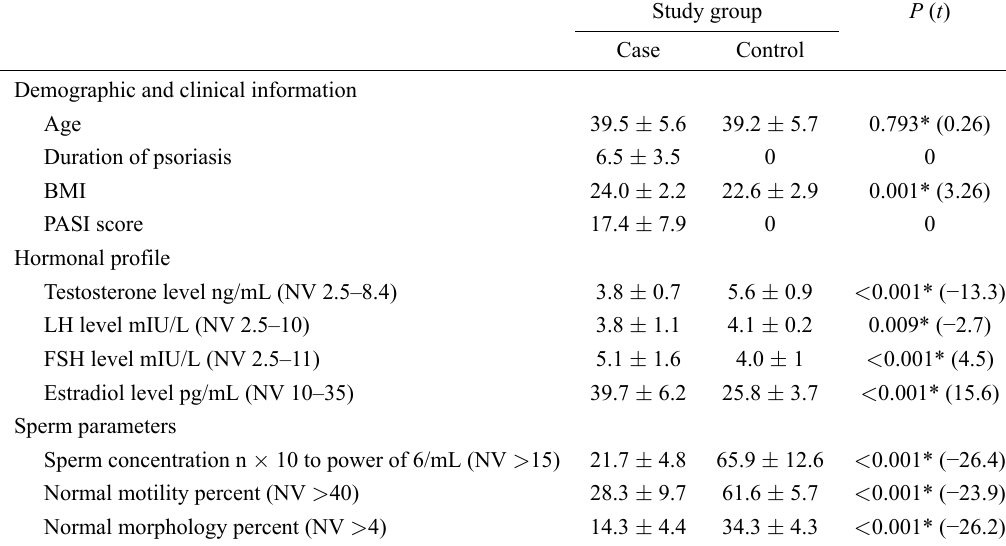
Table 1. Demographic, clinical, and sperm and hormonal parameters of psoriasis